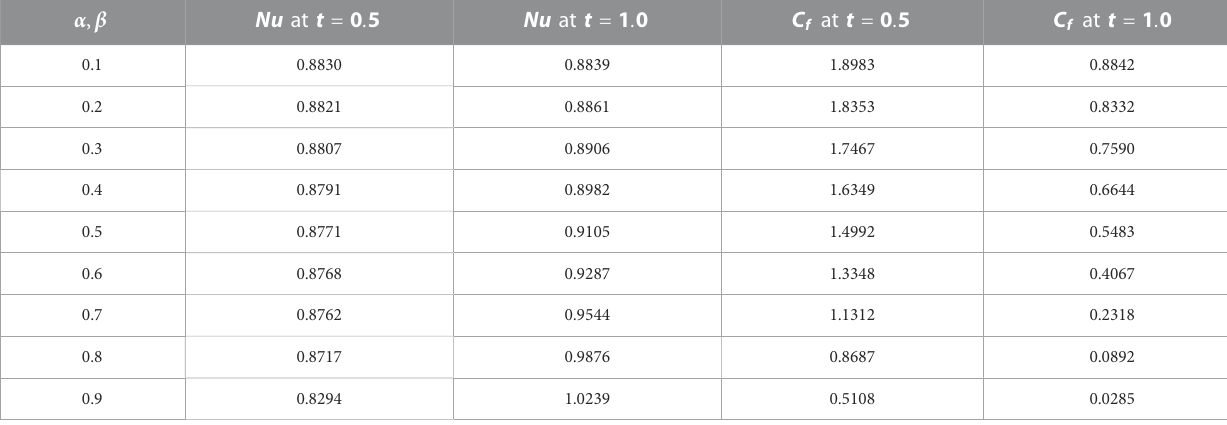
TABLE 5 Numerical analysis of the Nusselt number and skin friction coef fi cient at different times. α , β Nu at t (cid:2) 0 . 5 Nu at t (cid:2) 1 . 0